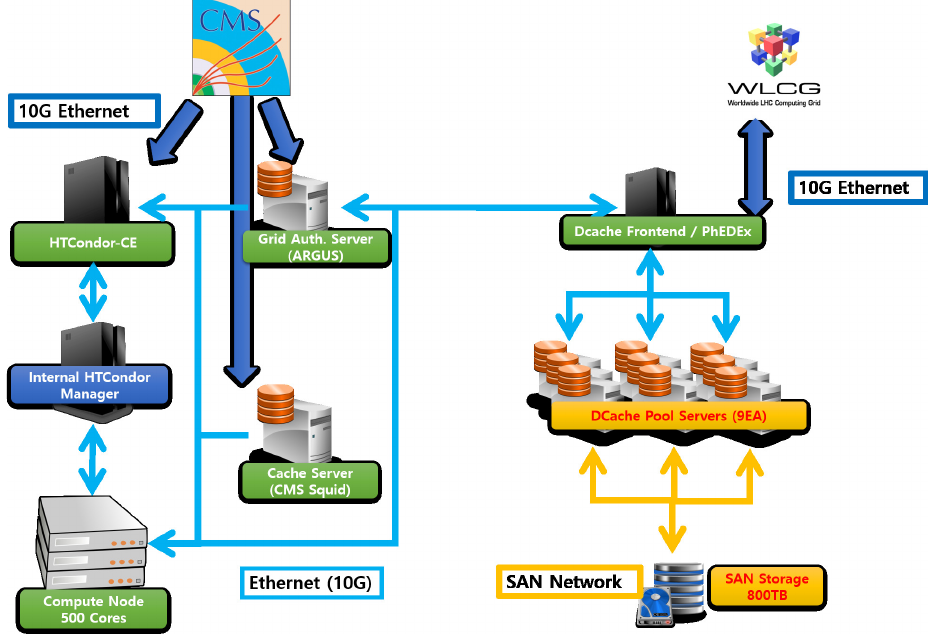
Figure 1. KISTI CMS The Tier-2 center consist of HTCondor-CE and dCache SE